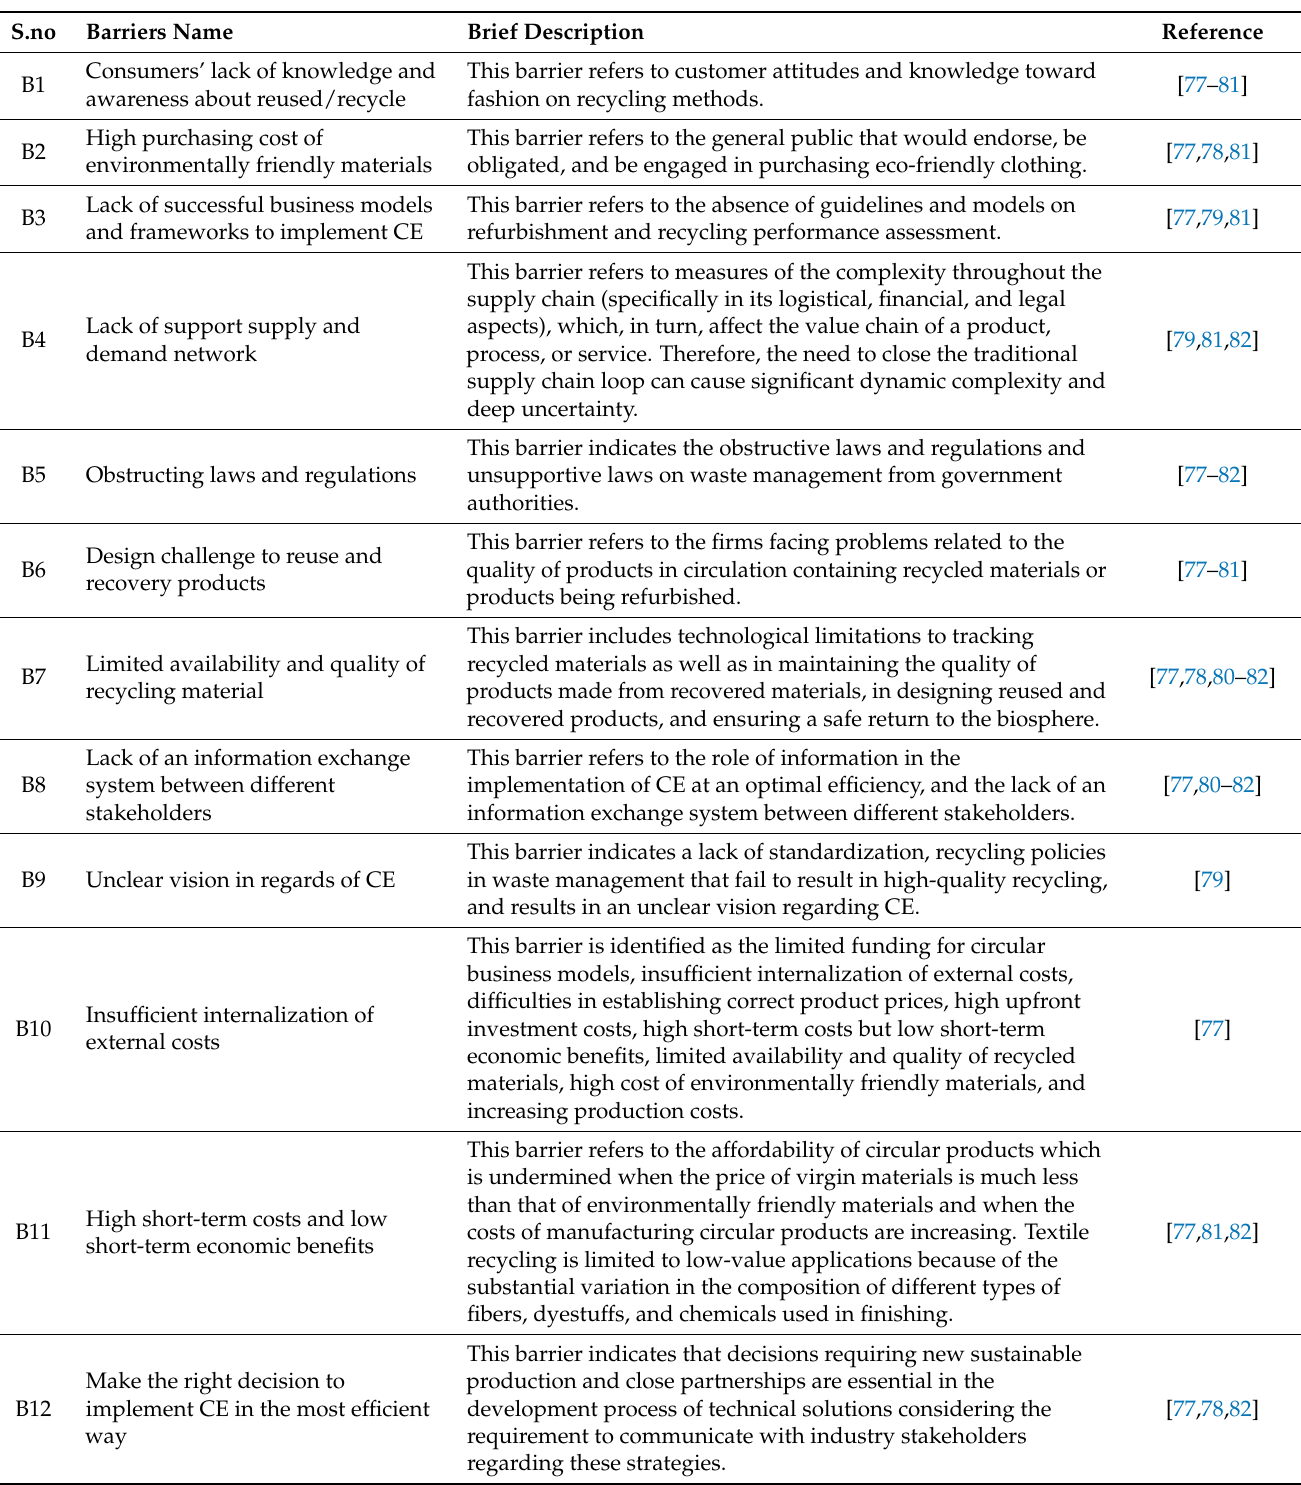
Table 1. The CE barriers with